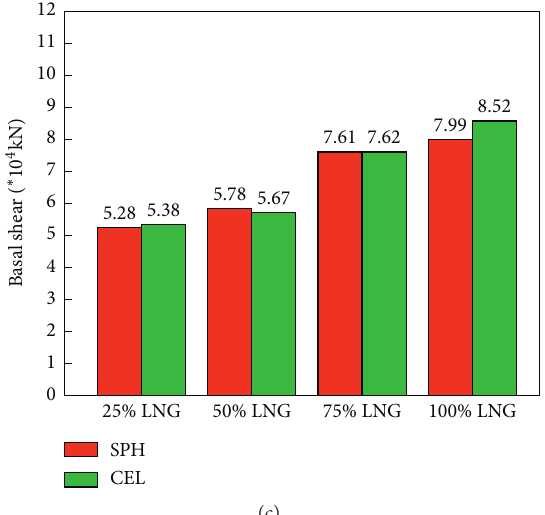
Figure 18: Comparison of the maximum base shear under different liquid volume between the two algorithms. (a) El Centro, (b) Northridge, and (c)